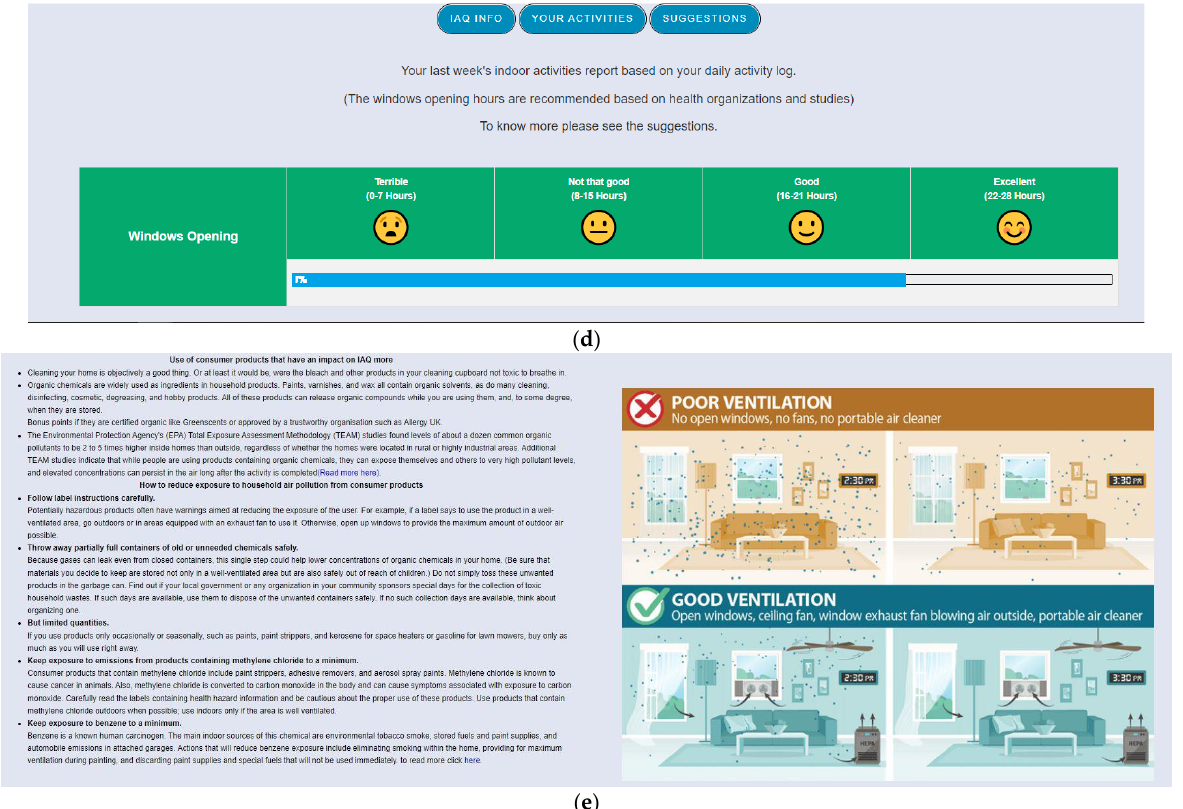
Figure 5. ( a ). An interactive pop-up to provide instant information about IAQ improvement. ( b ). An